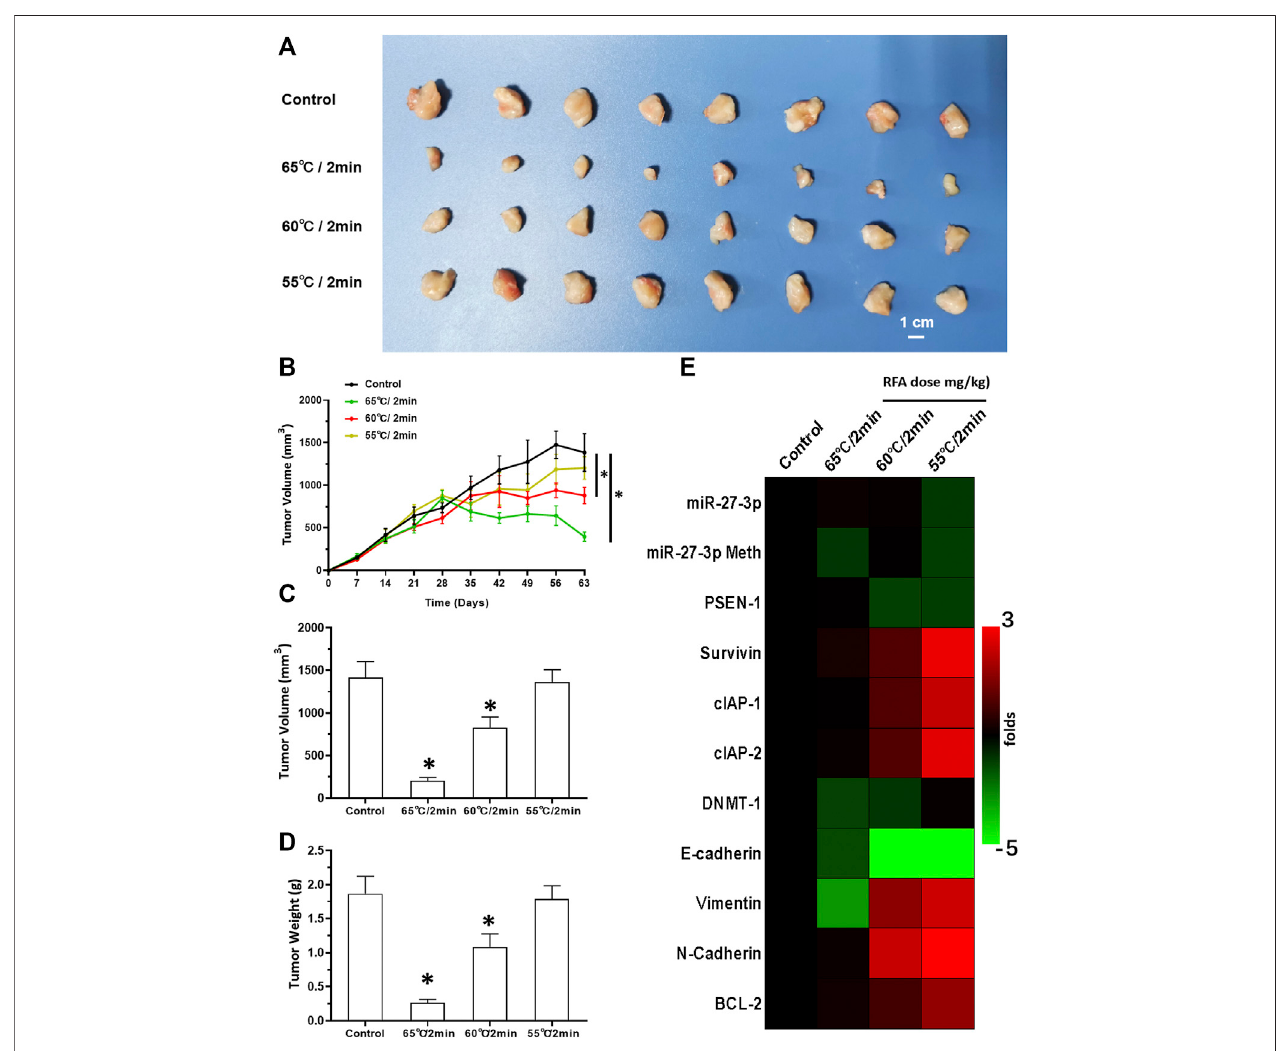
FIGURE7 | RFA treatmentinhibits subcutaneousgrowth ofH226 LSCC cells in nudemice. (A) Images of tumor tissues. (B) Tumor growth curves. (C,D) Volumes andweightsofthetumortissuesaredisplayedashistograms. (E) EffectofRFAontheexpressionofNotchpathway-relatedfactorsisshownasaheat-map.Comparison between the iDNMT group and control group. * p <